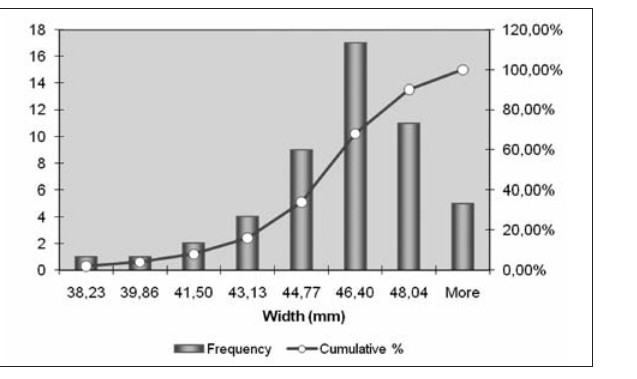
Fig. 32: Distribution of width values of category AA of Bergeron apricot